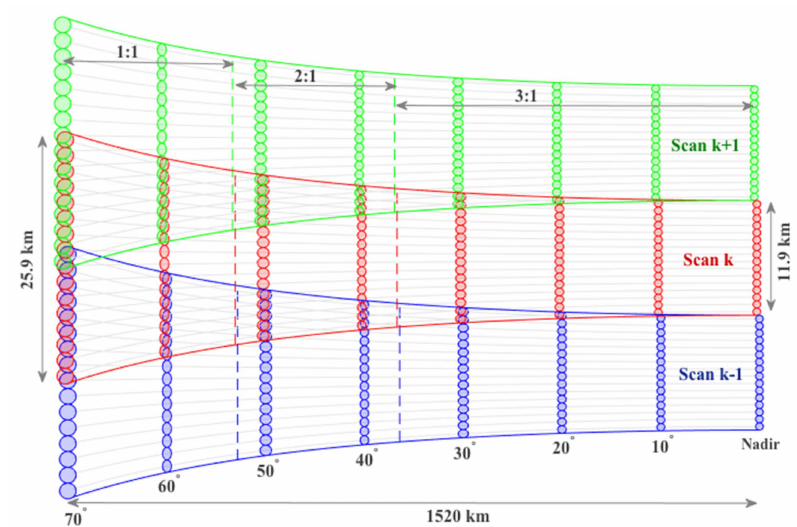
Figure 2. Schematic representation of VIIRS sampling for three consecutive whiskbroom (rendered in blue, red and green respectively), for several selected VZAs from 0 ˝ (nadir) to 70 ˝ (approximately representing the left edge of the scan) in 10 ˝ increments. The two axis of each ellipse represent the horizontal and vertical sampling intervals, respectively. The vertical dashed lines show positions where the aggregation factor changes.